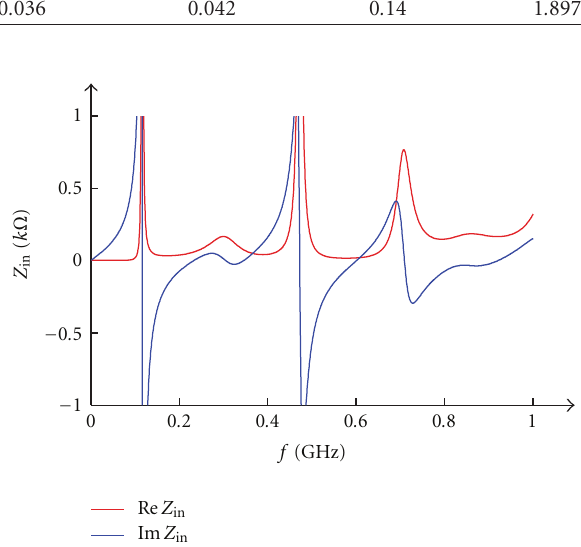
Figure 9: Input impedance of the array depicted in Figure 8.